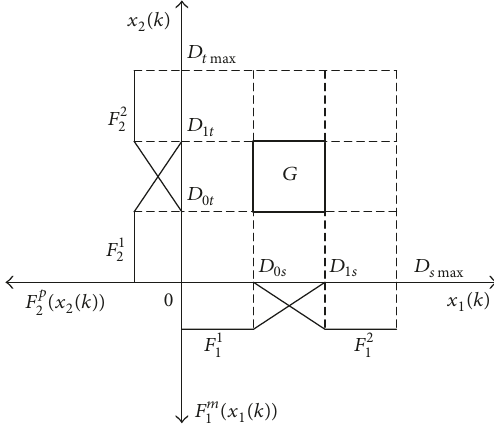
Figure 3: Fuzzy membership